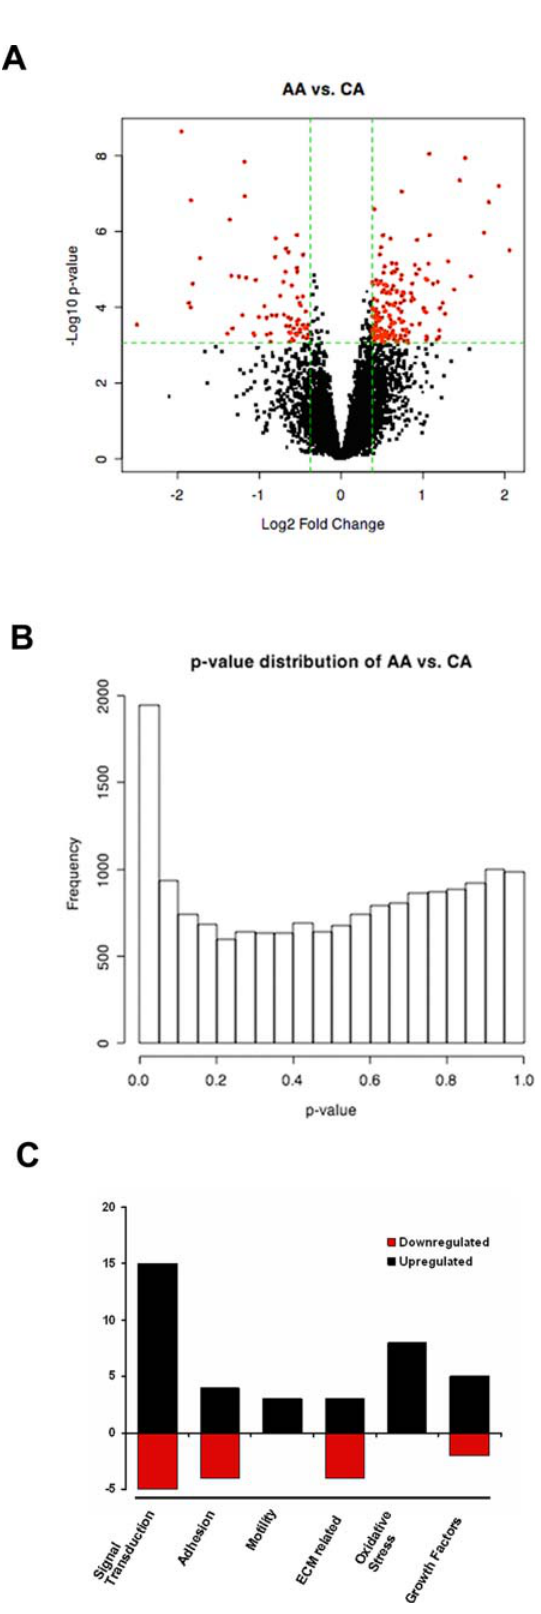
Figure 1. Differential gene expression in primary cultures of ONH astrocytes from age-matched normal donors (12 AA and 12 CA). A. Volcano plot indicates the size of biological effect (fold change) versus the statistical significance of the result (statistical